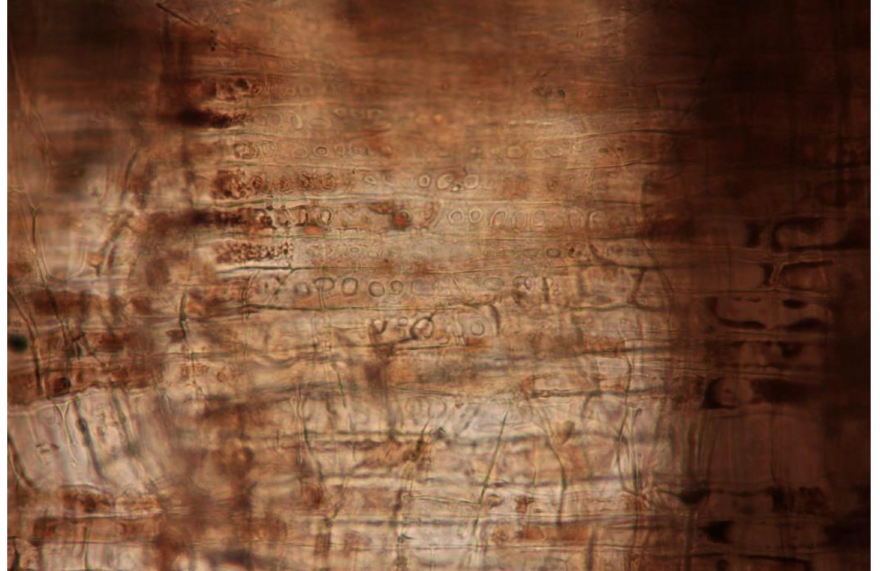
Figure 7. Light microscope image of a radial-longitudinal section of a Quercus spp. wood belonging to the White oak group (400 × ). Vessel-ray pitting with much reduced borders to apparently simple. The pits are rounded or angular. The wood sample belongs to one out of a number of piles forming a retaining wall found to the east of Lechaion’s ancient harbour entrance canal during underwater excavations in Greece. Image: A. Zisi, © Lechaion Harbour